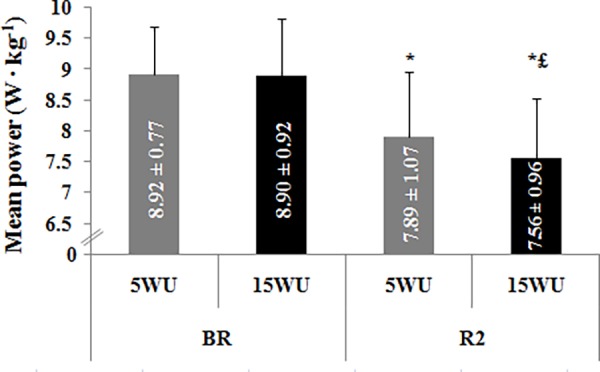
Mean power (W ∙ kg−1) (mean ± SD, n = 12) determined during the 30-second Wingate test, after the 5-minute (5WU) and the 15-minute (15WU) warm-up, before (BR) and during (R2) Ramadan.*: significant difference in comparison with BR. £: significant difference in comparison with the 5-minute warm-up.